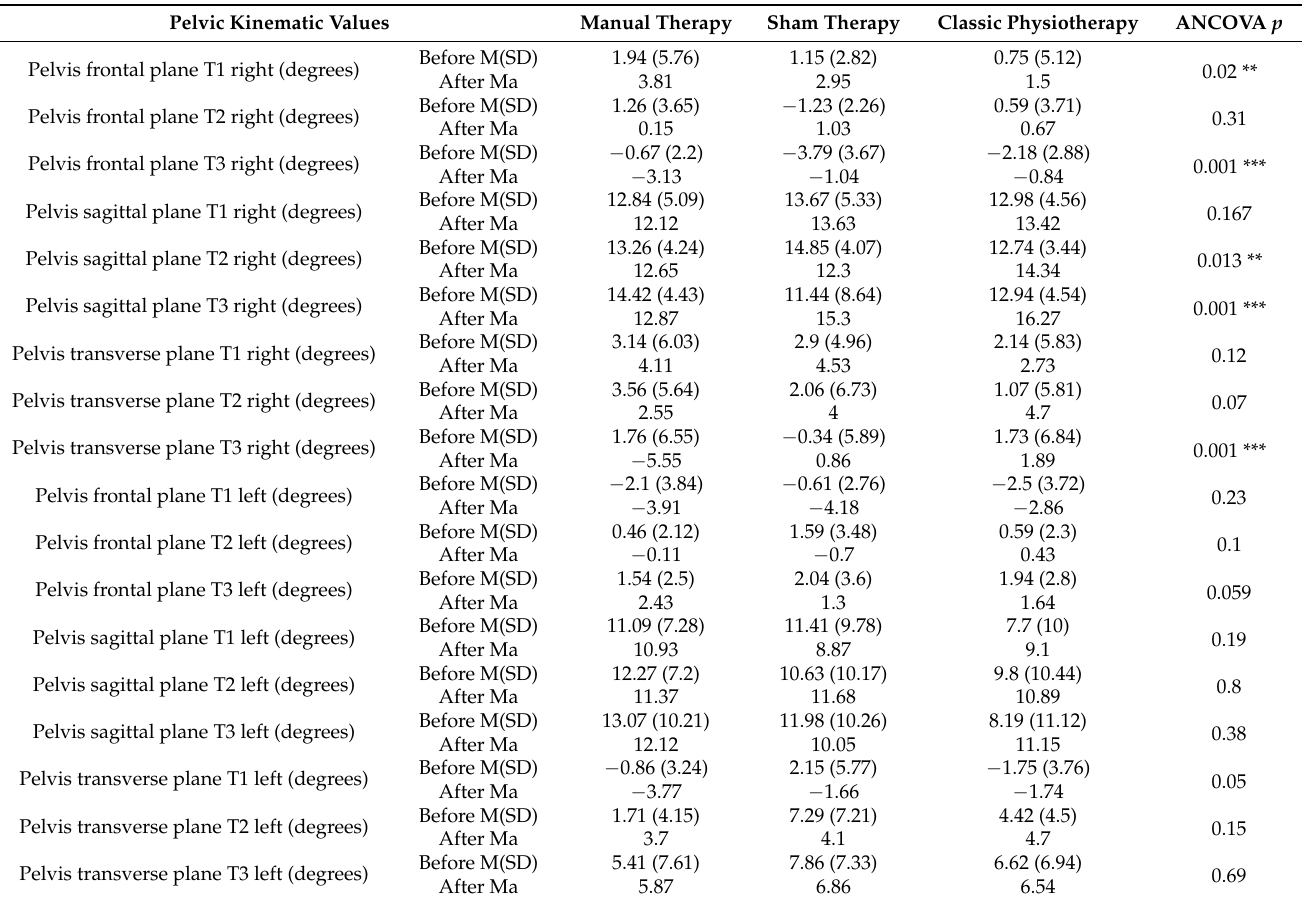
Table A3. ANCOVA results in pelvic kinematics.